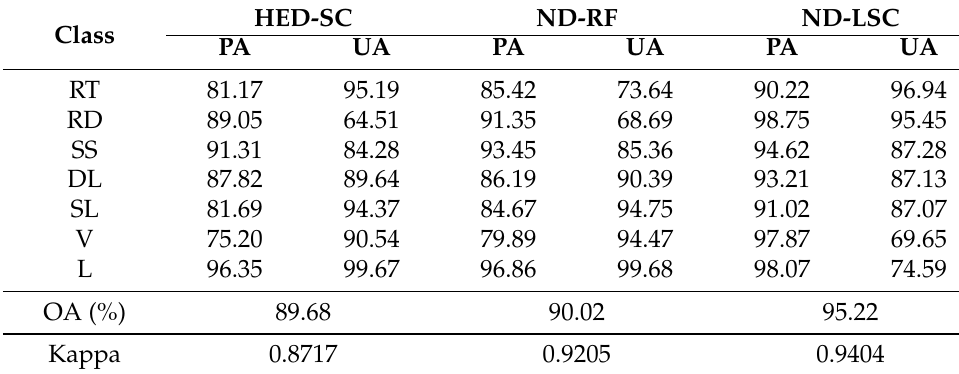
Table 4. Confusion Matrix of the ND-I SC Method (PA: %; UA: